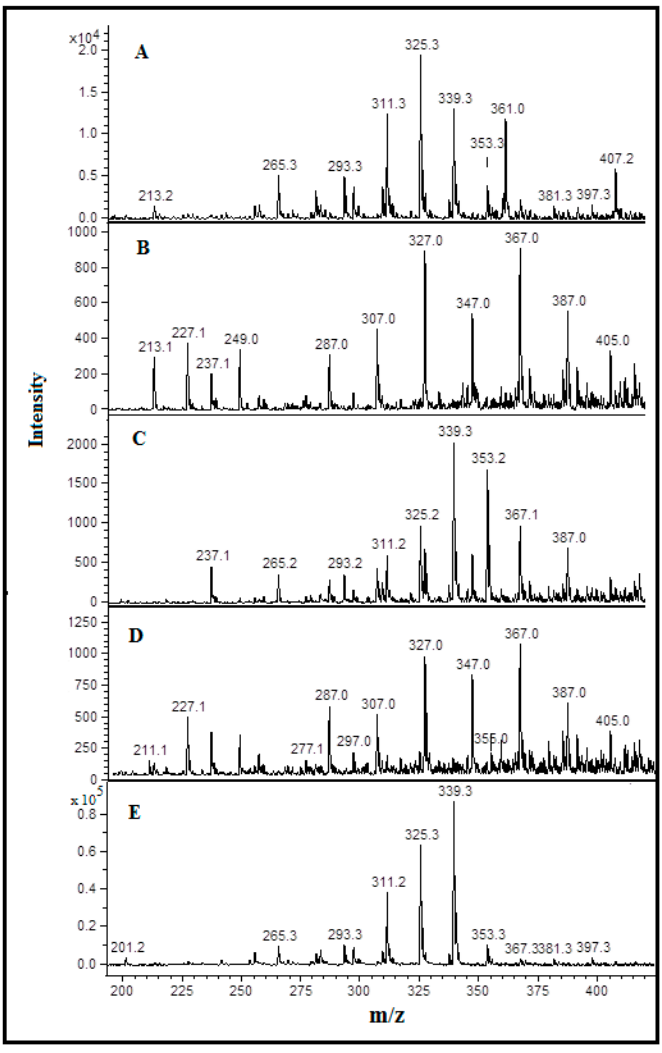
Figure 2. Lipid profiles of salted meats at initial days of storage i.e., at T0, ( A ) control; ( B ) FC1: 100% NaCl; ( C ) F1: 50% NaCl + 50% KCl; ( D ) F2: 50% NaCl + 50% CaCl 2 ; ( E ) F3: 50% NaCl + 25% KCl + 25% CaCl 2 obtained in ESI-MS in negative ion mode.